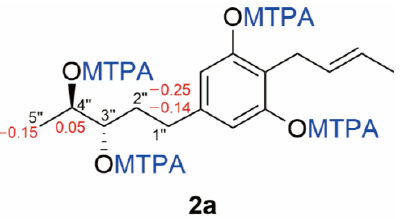
Figure 5. The structures and ∆ δ S - R values (in ppm) for MTPA esters 2a of compound 2 . Compound 3 was obtained as a white solid, and its molecular formula was established as C 13 H 14 O 4 (seven degrees of unsaturation) according to the ion peak cluster at m/z